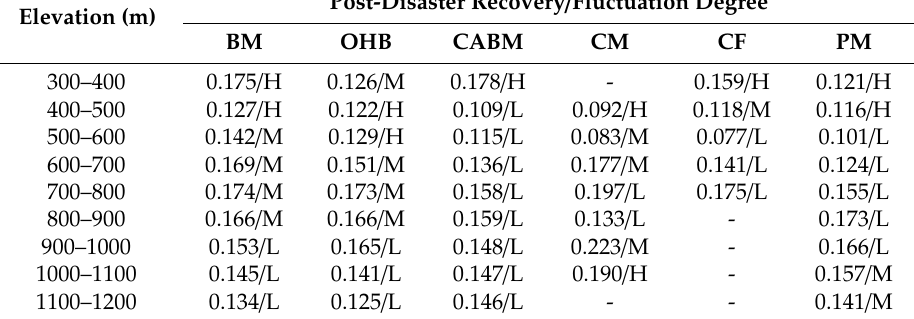
Table 13. Post-disaster recovery and fluctuation degree analysis results for six forest types in di ff erent elevation zones.